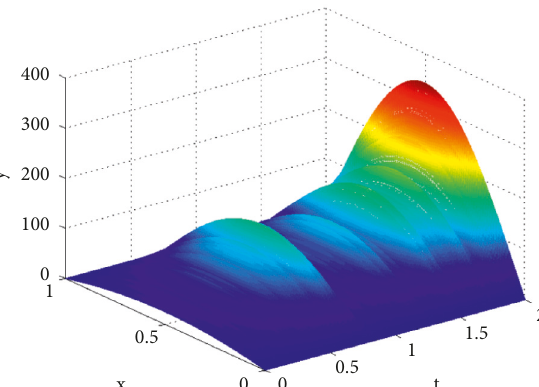
Figure 1: A sample path of the solution u ( x,t ) to equation (1) without control.